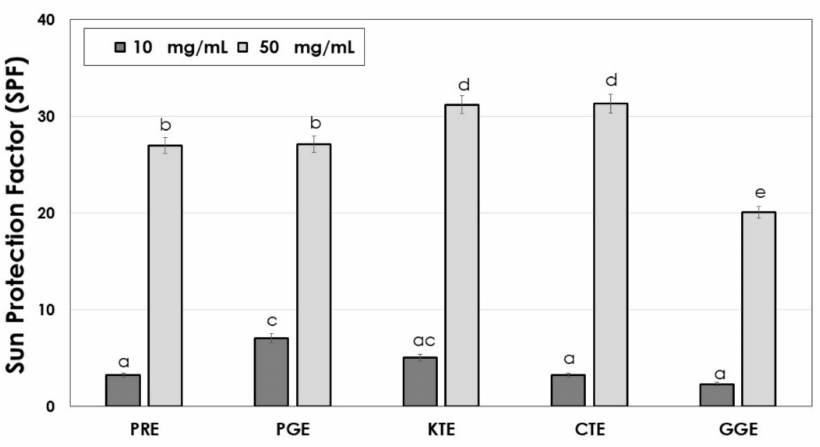
Figure 8. Ability of PRE, PGE, KTE, CTE and GGE extracts to protect against UV radiation. It was shown the analyzed plant extracts are characterized by high SPF factors. At the concentration of 50 mg/mL, the KTE and CTE extracts reach the highest SPF value (SPF of about 31) due to the strong ability to absorb UV radiation. Slightly lower values (SPF of about 28) were demonstrated for the PRE and PGE extracts and the lowest SPF value (SPF of about 20) was observed for the GGE extract. Kora´c and Khambholia indicated that active ingredients of plants with the greatest impact on the SPF are quercetin, cyanidin, apigenin, caffeic, quinic and ferulic acid, as well as silymarin, resveratrol, juglone, ascorbic acid, tocopherols, and carotenoids [65]. Ranjithkumar et al. showed that